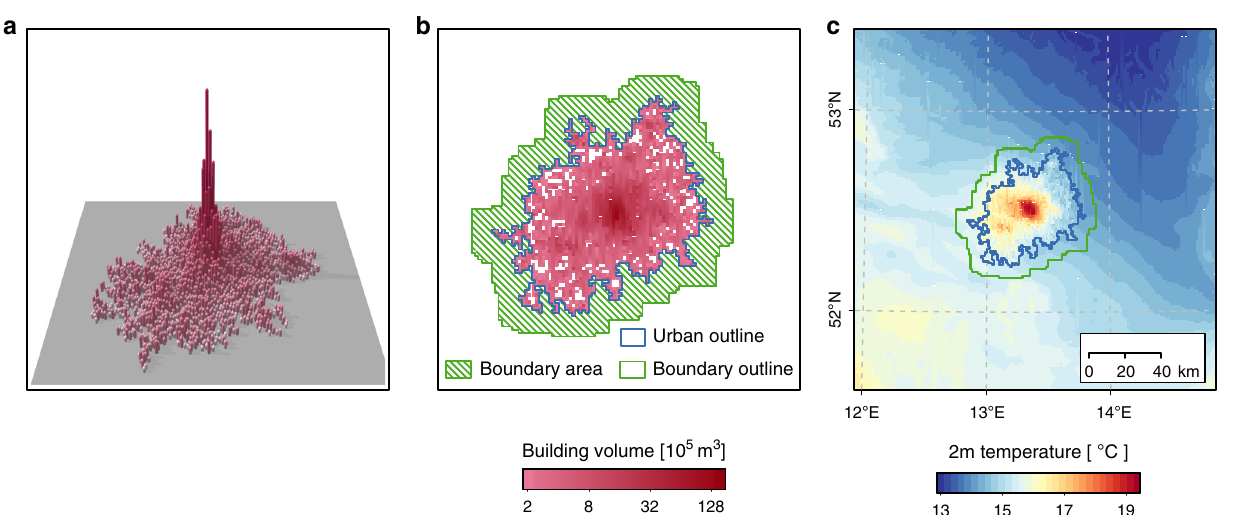
Fig. 1 Example of generated urban clusters and resulting heat patterns. a Three-dimensional illustration of average building height in each grid cell of a considered cluster. b Gross building volume in the cluster together with cluster edge and surrounding boundary. c Simulated temperature fi eld at night (02:00 local time). The UHI intensity is de fi ned as Δ T = 〈 T C 〉 − 〈 T B 〉 , where 〈 T C 〉 and 〈 T B 〉 are the average 2-m air temperatures in the city (blue line) and boundary (green line),